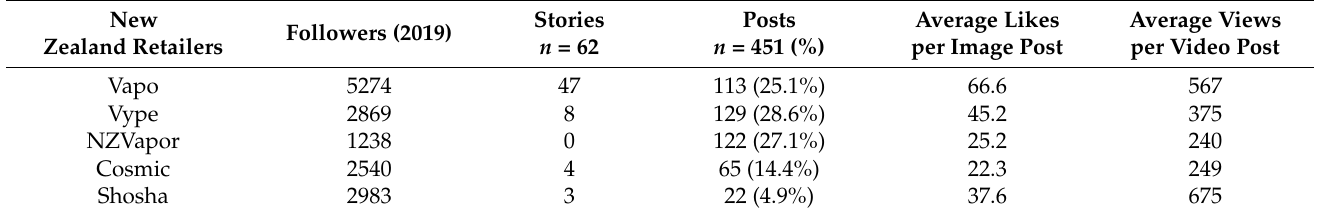
Table 1. New Zealand e-cigarette retailer Instagram followers, posts, and